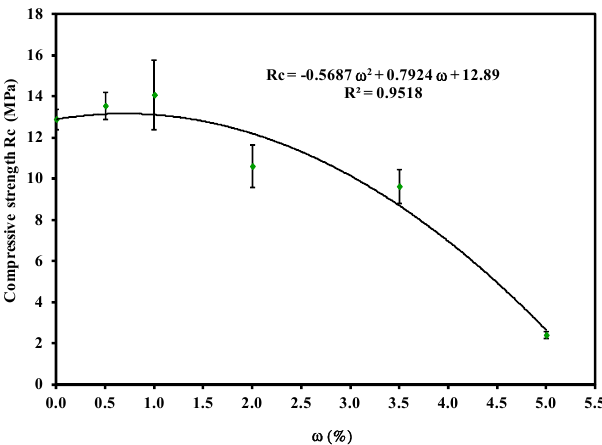
Figure 14. Variation of compressive strength with AF mass content at day 28. Measurements uncertainty is below 12%.